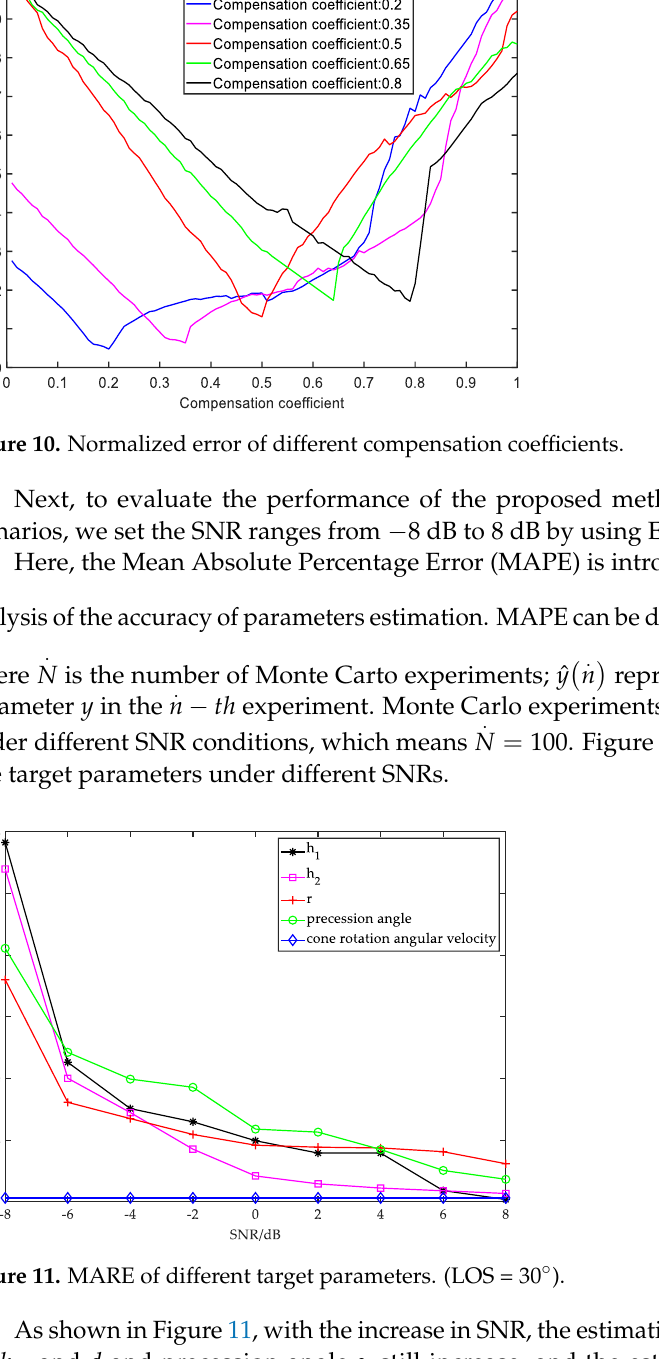
Figure 12. MAPE of different target parameters. (SNR = 4 dB). In order to verify the effectiveness of the method, the proposed parameter estimation method is compared with the methods in [11 – 14]. The results shown in Table 3 indicate that the MAPE under different SNRs of the parameter estimation method proposed in this paper is obviously lower than methods in [11 – 14]. Table 3. MARE of estimated parameters with different methods. SNR (dB)